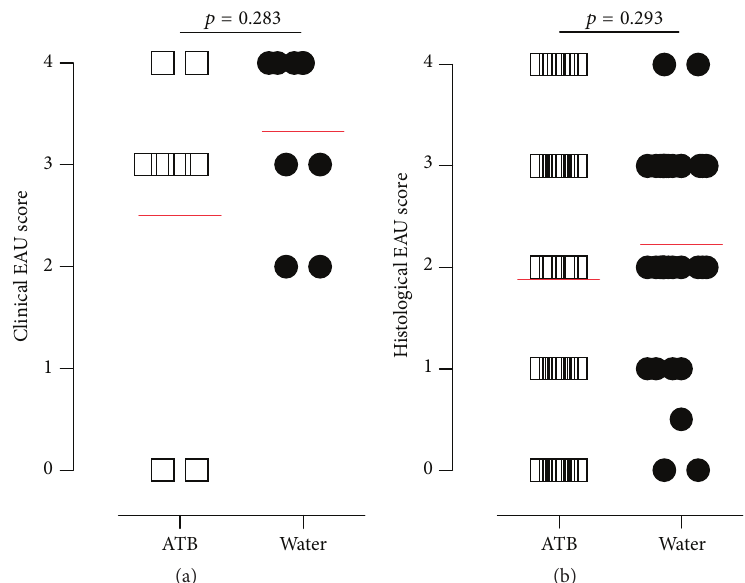
Figure 3: Antibiotics (ATB) administered from the day of EAU induction do not reduce the EAU severity. Quantification of (a) clinical and (b) histological EAU score at day 35 after induction is shown. The clinical data are from one of several independent experiments (ATB 11 mice, water 15 mice). The red lines in the graphs represent mean.